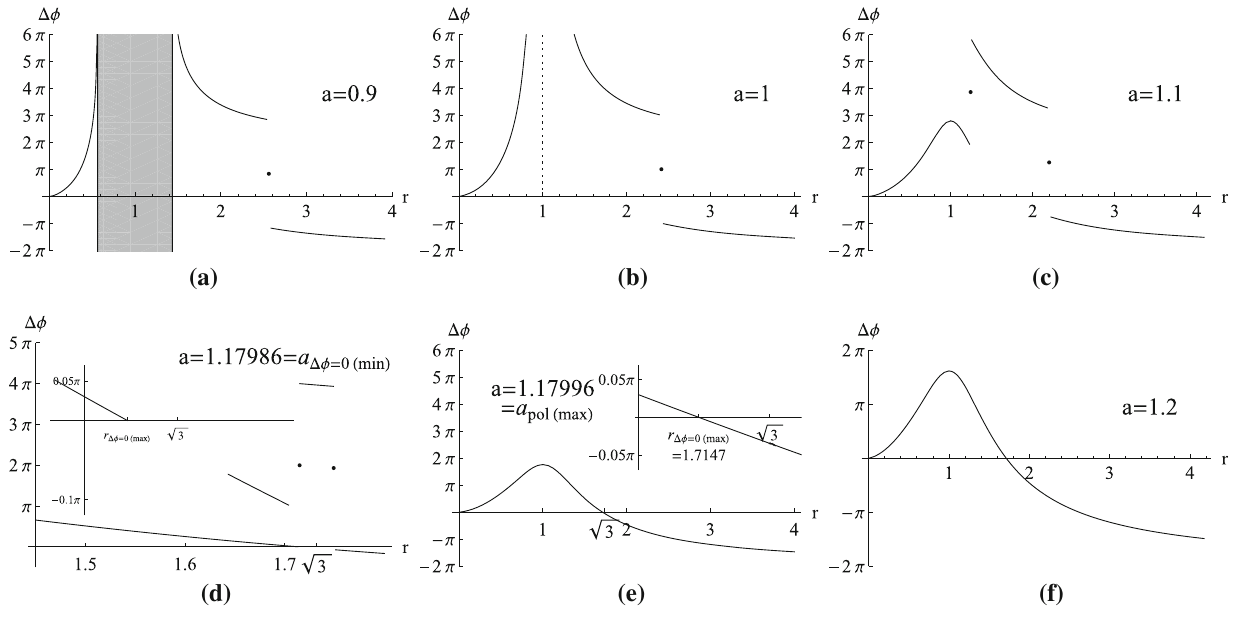
Fig. 6 Dependence of the node shift (cid:4)φ on the radius of the spheri- cal orbit. A discontinuity occurs at r = r pol ± the jump change is 2 π between the single point and each of the end points of the curve, c. f. [58]. For a = a pol ( max ) = 1 . 18 the points of the discontinuity coalesce √ at r = r pol = 3 . For a > a pol ( max ) the function is continuous. The